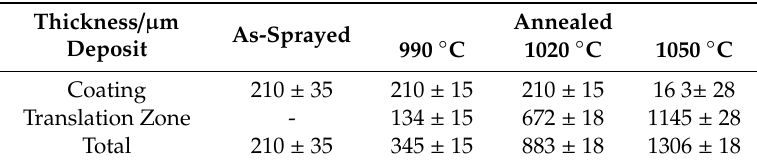
Figure 5. Relation of the transitional zone thickness to annealing temperature. Table 3. Thickness of the coatings and translation zone.